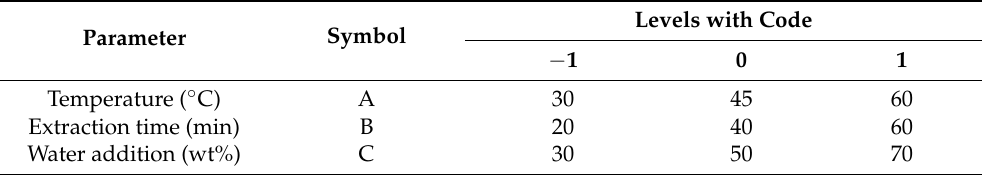
Table 1. Box–Behnken design of experiment parameters.